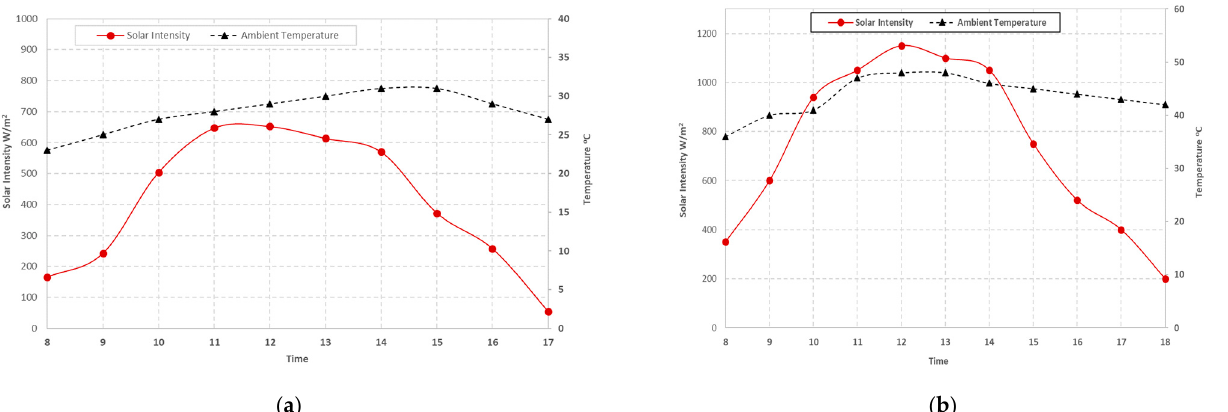
Figure 11. Hourly variations in ambient temperature and solar intensity ( a ) during Winter day ( b ) during Summer